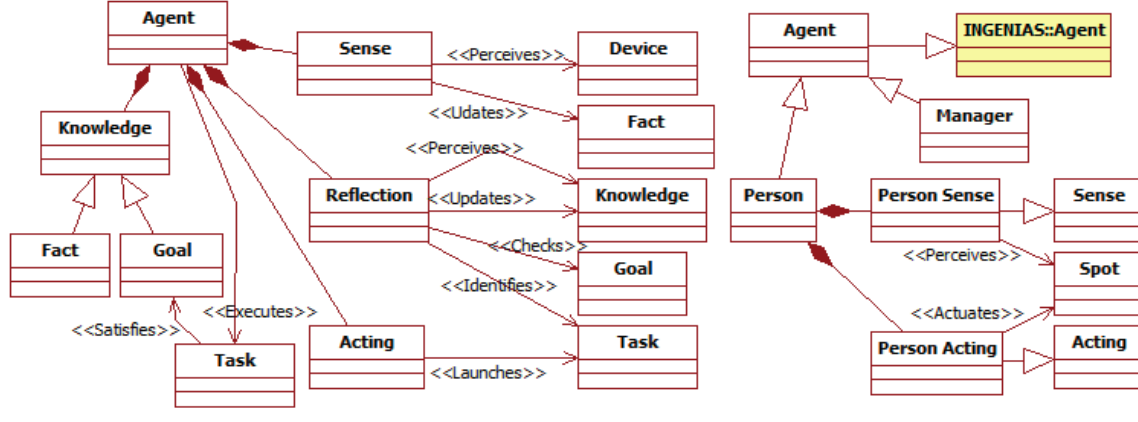
Figure 5. Partial ITS metamodel. Person and Manager related